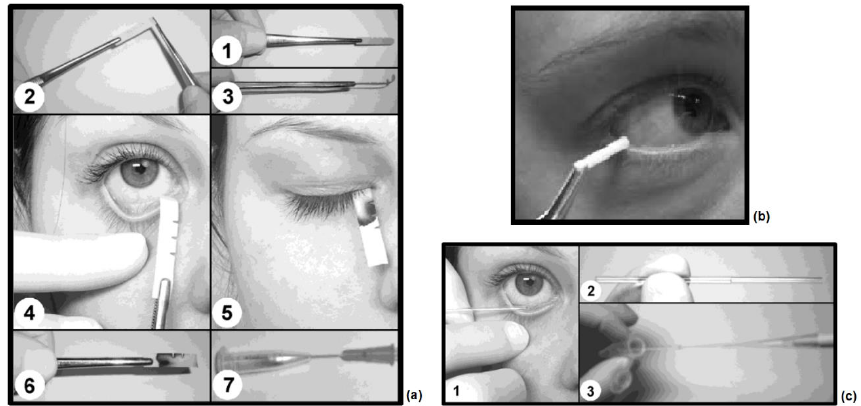
Figure 1. Tear fluid collection methods. ( a ) Sampling with Schirmer’s test: The filter paper is folded over at right angles (1–3) and inserted into the lower conjunctival sac above the punctum lacrimale using a forceps (4). During sampling, eyes are kept closed in neutral position (5). For removal with forceps, eyes are opened, the lower lid is pulled down and the strip is removed by pulling it upward and out of the eye (6); after an average time of 5 min, the strip is completely moistened. Test strip transferred into a collection tube (7) (Reprinted with permission from Ref. [36]. Copyright 2012 Elsevier). ( b ) Sampling with surgical sponge rod: While the rod tip is resting in the lower tear meniscus, cellulose rod is placed close to the lower lid by holding a forceps (Reprinted with permission from Ref. [37]. Copyright 2008 John Wiley and Sons). ( c ) Sampling with capillary tube: To obtain tear fluid, the lower lid is pulled downward and while holding the tube laterally from the inferior temporal tear meniscus toward the outer canthus of the eye (1), a capillary tube extracts tear fluid from lower cul-de-sac (2) and extracted samples are transferred into a collection tube (3) (Reprinted with permission from Ref. [36]. Copyright 2012